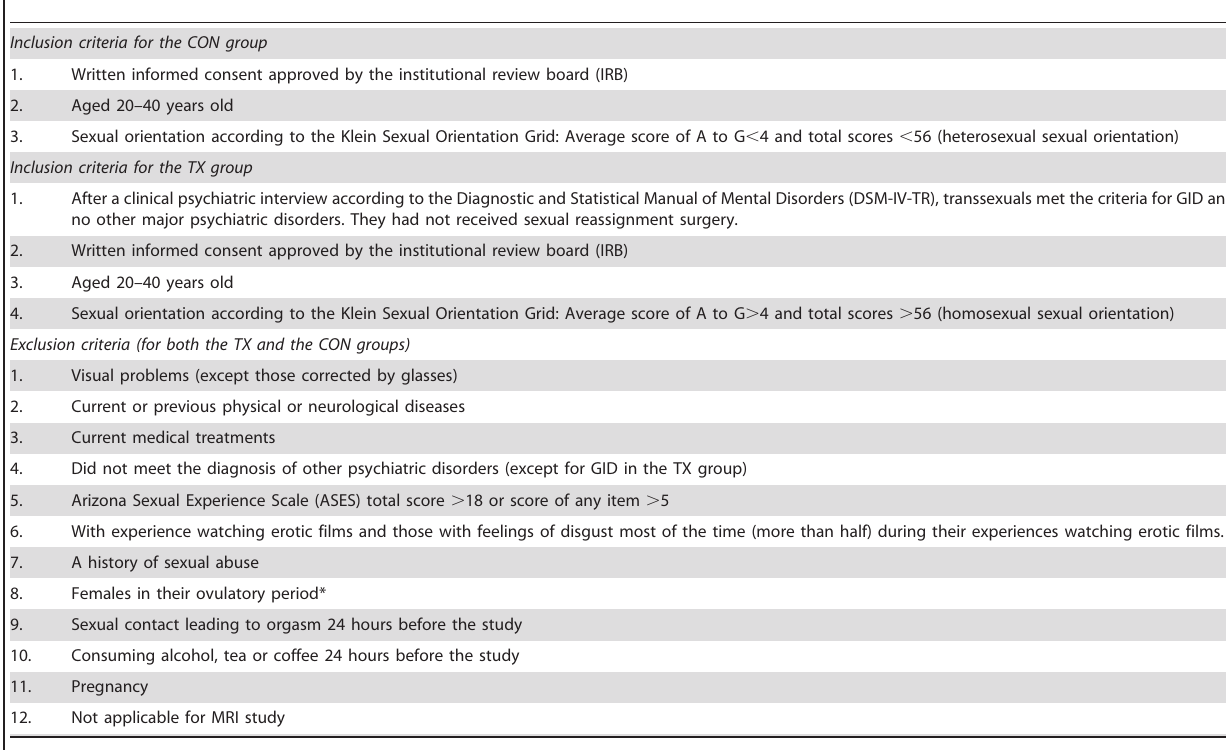
Table 1. Inclusion and exclusion criteria for the TX group and the CON